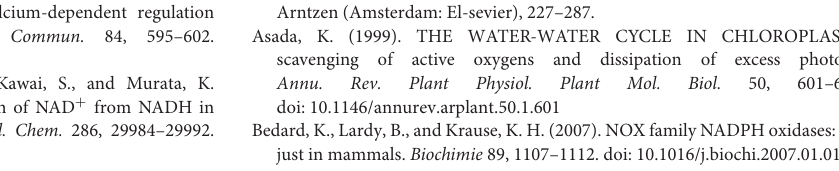
Figure S1 | Developmental expression patterns of NADK family genes in plants. Expression profiles of nine plant NADK families at different developmental stages were obtained from the microarray data and mRNA sequence data reported by Genevestigator V3 (https://genevestigator.com/gv/). These NADK families include in four eudicotyledons plants, AtNADK s (A) , SlNADK s (B) , GmNADK s (C) , and MtNADK s (D) , and in four liliopsida plants, OsNADK s (E) , HvNADK s (F) , ZmNADK s (G) , SbNADK s (H) , and TaNADK s (I) . Results were shown as heat maps with white/gray/red (low to high) that reflect the percentages of the gene expression. Figure S2 | Anatomical expression patterns of NADK family genes in plants. Expression profiles of nine plant NADK family genes in different tissue anatomical structures were obtained from the microarray data and mRNA sequence data reported by Genevestigator V3 (https://genevestigator.com/gv/). These NADK gene families include in four eudicotyledons plants, SlNADK s (A) , GmNADK s (B) , MtNADK s (E) , and AtNADK s (I) , and in five liliopsida plants, SbNADK s (C) , HvNADK s (D) , OsNADK s (F) , TaNADK s (G) , and ZmNADK s (H) . Results were shown as heat maps with white/gray/red (low to high) that reflect the percent of expression. Figure S3 | Expression patterns of NADK family genes in eight plant species under abiotic and biotic stresses and hormone treatments. Expression profiles of eight plant NADK family genes were obtained from the microarray data and mRNA sequencing database data reported in Genevestigator V3 (https://genevestigator. com/gv/). These NADK gene families include in Arabidopsis thaliana (A) , Oryza sativa (B) , Triticum aestivum (C,E) , Zea mays (D) , Hordeum vulgare (F) , Medicago truncatula (G) , Glycine max (H) , and Solanum lycopersicum (I) . These profiles illustrate differential expression of NADK families from different plants under different abiotic and biotic stresses and hormone treatments including pathogen, cold, drought, heat, salt, submergence, ABA, GA3, IAA, JA-like, NAA, and SA. Results were shown as heat maps with green/dark/red which represent the indicated relative signal values; where greener represents stronger down-regulated expression and redder represents stronger up-regulated expression as compared to the